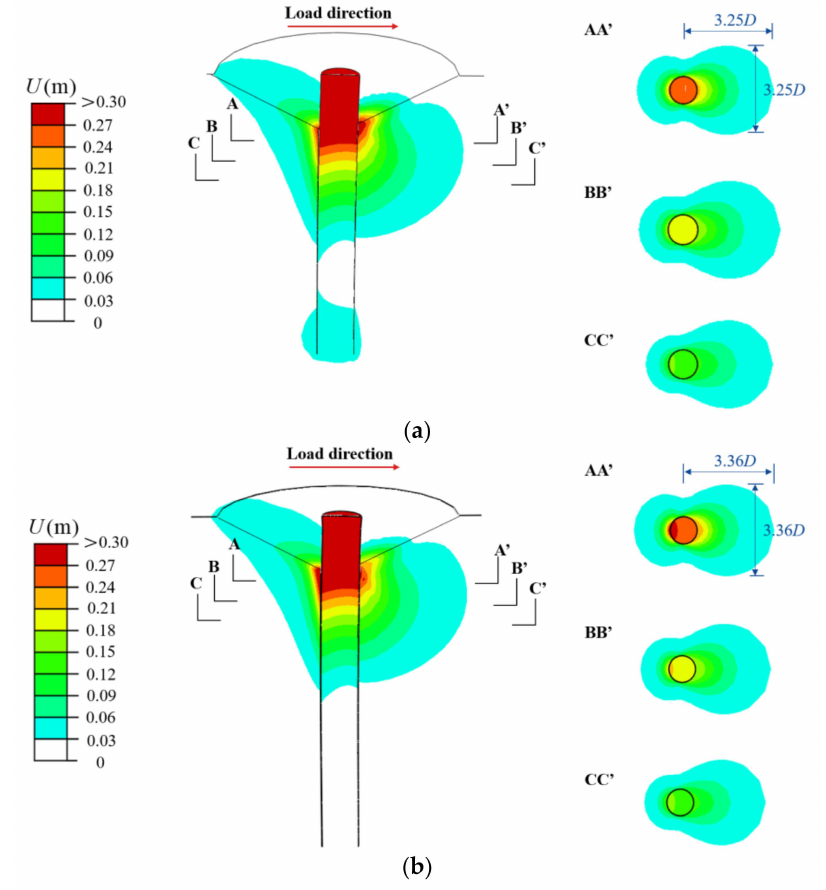
Figure 14. Soil displacement in the plane of symmetry and the planform at θ = 2 ◦ : ( a ) the regular monopile with scour ( S / D = 1.5); ( b ) the extended monopile with scour ( S/D = 1.5).